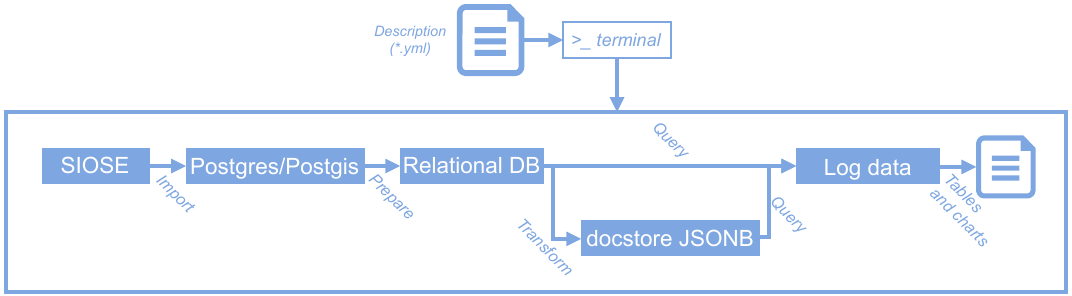
Figure 4. Computational experience in the SIOSE-INNOVA project